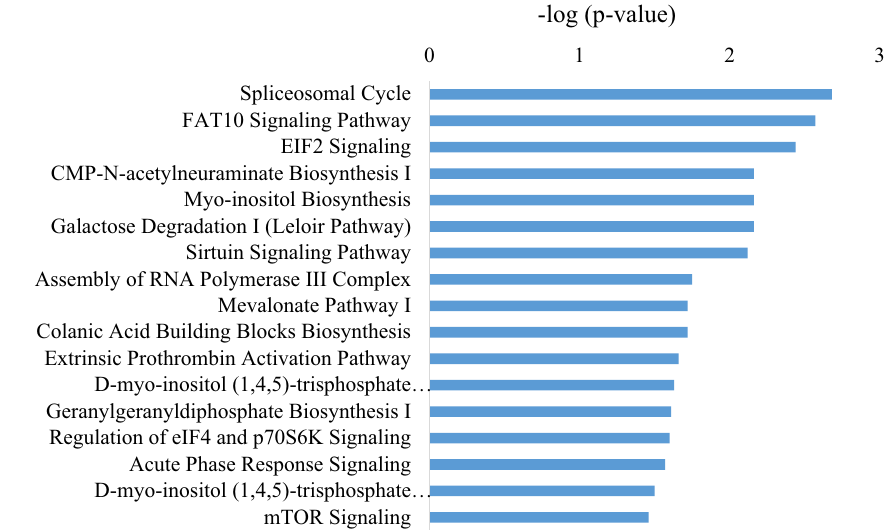
Figure 5. IPA analysis of top canonical enriched pathways in AT of HEF versus LEF groups. Top 18 canonical pathways related to feed efficiency of HEF versus LEF dairy cows on Y-axis and—log ( P -value) on the X-axis.